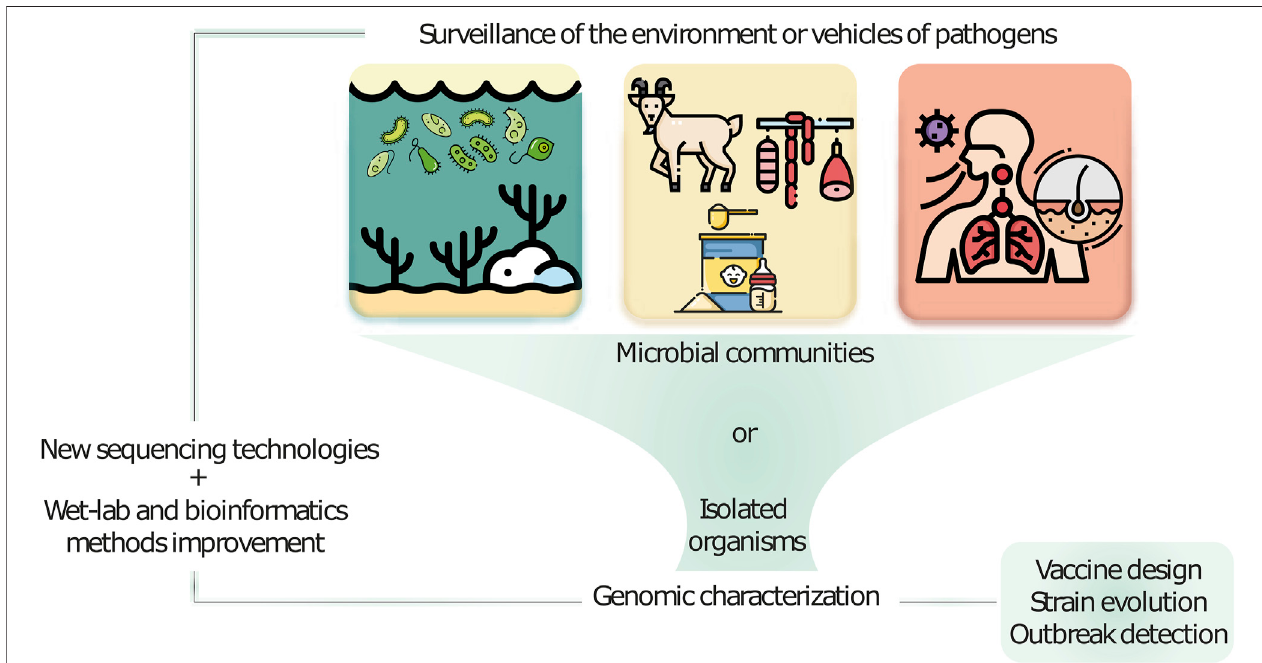
FIGURE 1 | New sequencing technologies in combination with further omics approaches and improved wet-lab and bioinformatics development advance microbial characterization and molecular surveillance of samples taken from various environments.